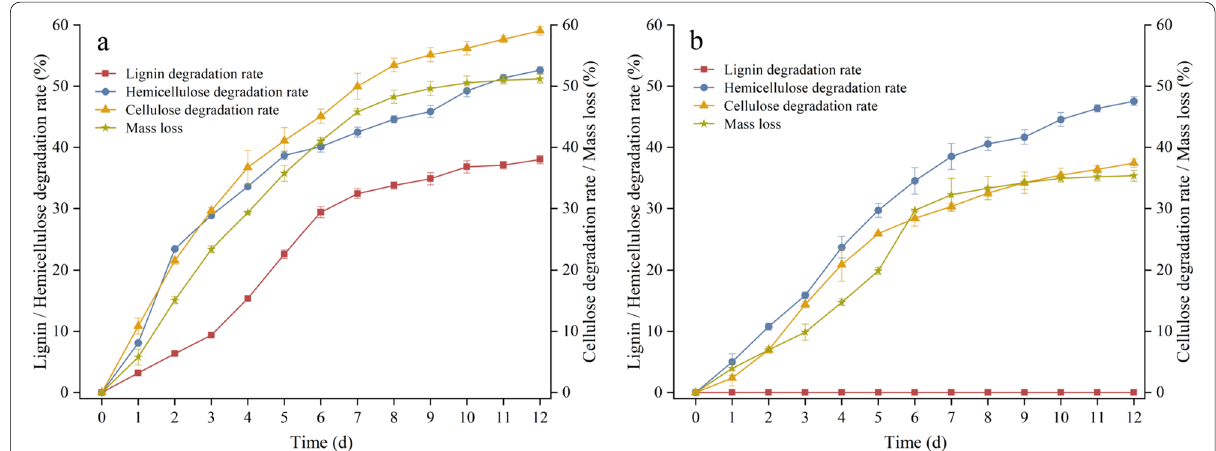
Fig. 4 Degradation of rice straw by T. reesei ZJ-09 ( a ) and original strain ( b ) under optimized SSF conditions. Error bars represent the standard deviation of three independent repeats